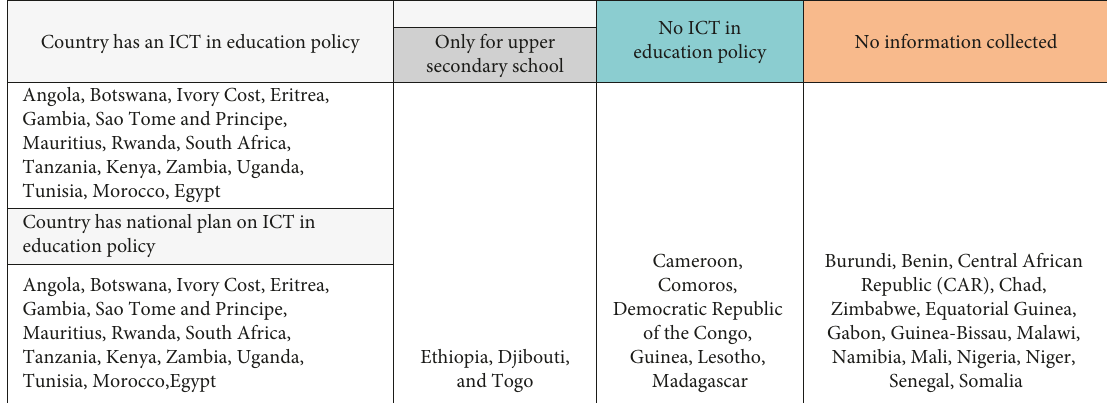
Figure 3: Policy and national plan on ICT in education in African countries (adapted from [35], under the creative commons attribution license/public